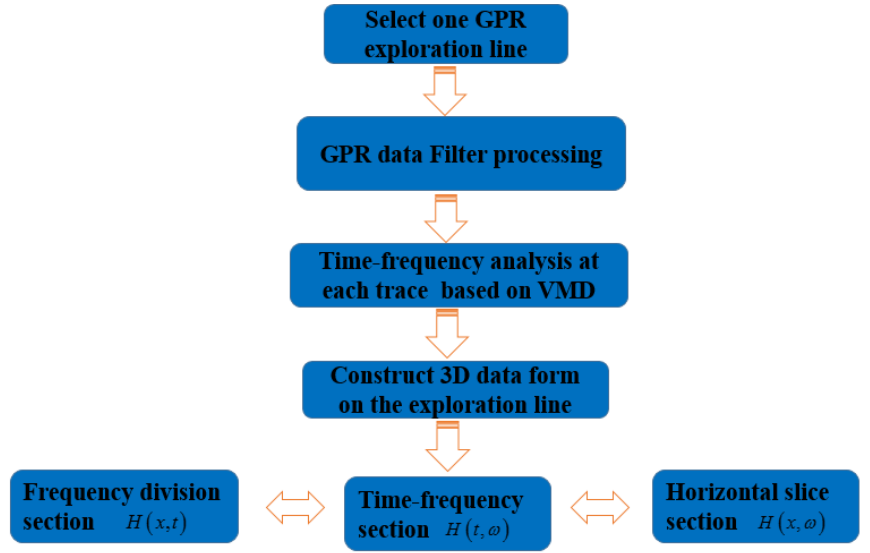
Figure 2. Ground penetrating radar (GPR) time-frequency analysis solving process.